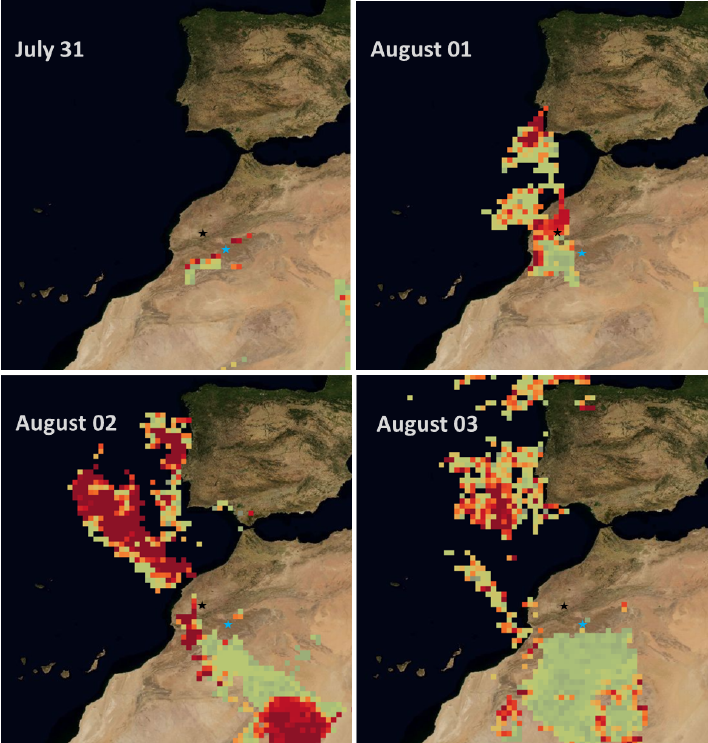
Figure 8. Dust Score layers acquired by AIRS instrument on the Aqua satellite, during the dust-storm event, consecutively on 31 July, 1, 2, and 3 August 2018. Pixels where the dust score is less than 400 are not shown. Images are adapted from the NASA Earth Data website (https://earthdata.nasa.gov (accessed on 5 April 2022)). The Saada and Ouarzazate sites are indicated with black and blue stars.